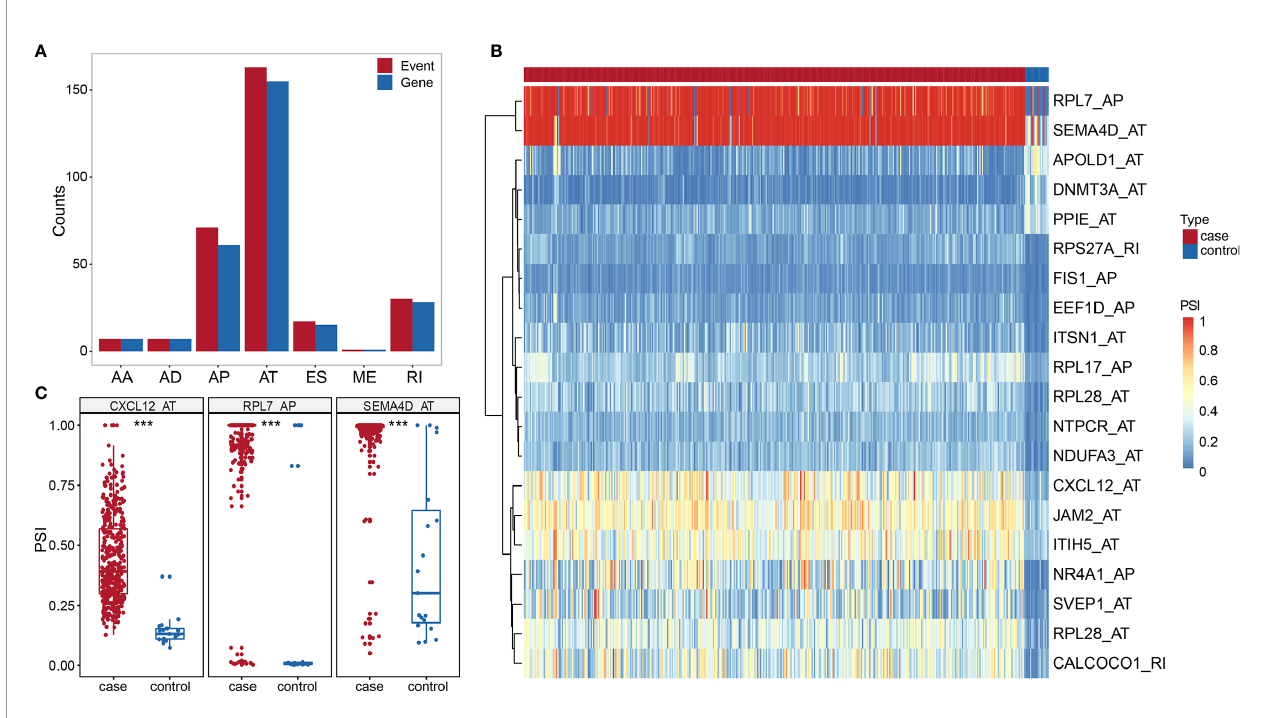
FIGURE 3 | (A) Histogram of DASE distribution in BLCA. (B) Heat map of the top 20 differentially AS events in BLCA. (C) Box plot of variable shear events among the top three alternative splice events in BLCA. *** represents p values <